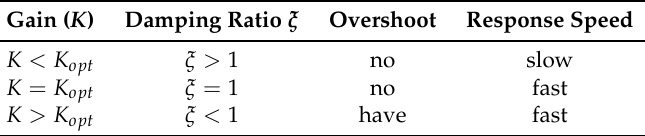
Figure 11. Output current response with different gains of K when an abrupt change happens in the reference current. Table 1. Evaluation for different value of K